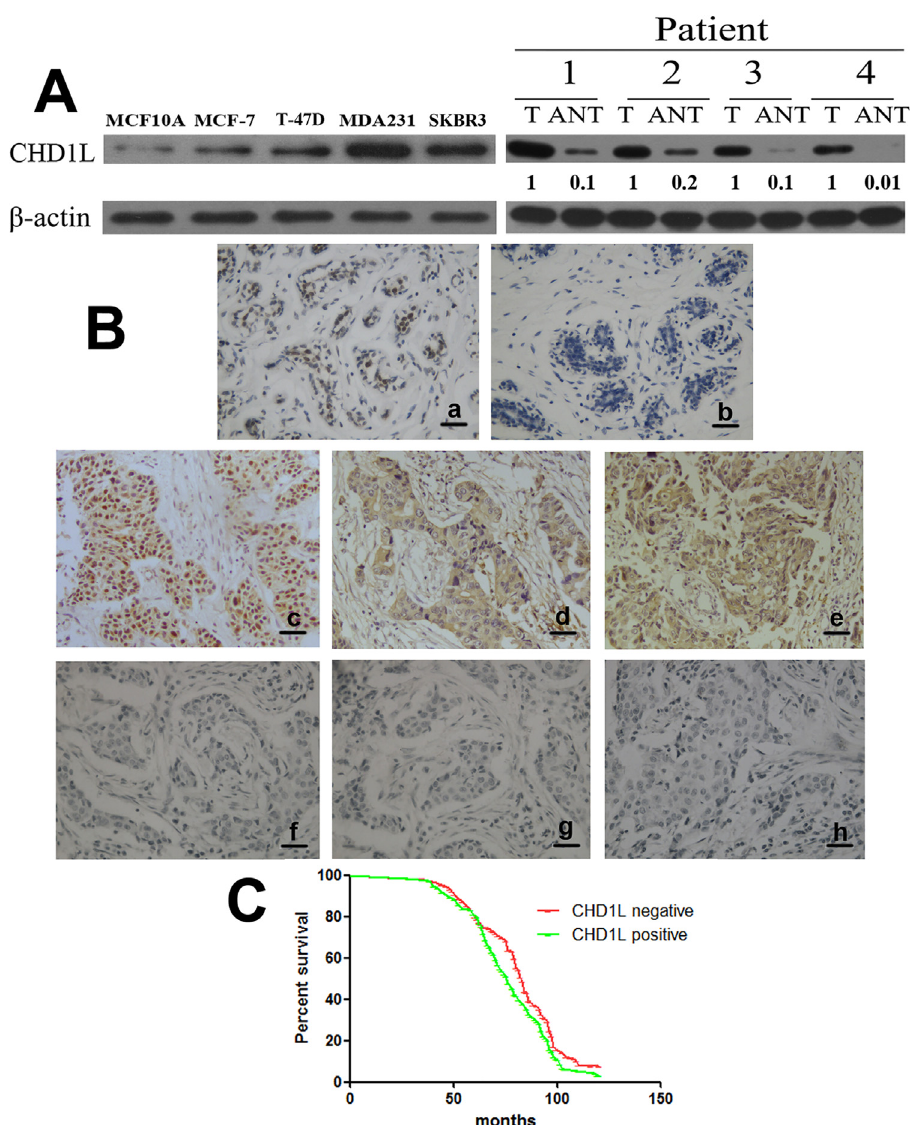
Fig 1. CHD1L is specifically upregulated in human breast cancer cell lines and tissues. (A) Left, Expression of CHD1L protein in cultured human normal mammary epithelial cell line (MCF10A) and various breast cancer cell lines (MDA-MB-231, T-47D, SK-BR-3, and MCF-7). Right, Expression of CHD1L protein in paired breast cancer tissues (T) and adjacent non-tumor tissues (ANT), with each pair obtained from the same patient. β -Actin was used as a loading control. Quantification of relative protein levels is shown below the blots. Results are representative of at least three repeated experiments. (B) Positive expression of CHD1L protein in normal mammary glands (a), negative expression of CHD1L protein in normal mammary glands (b), positive expression of CHD1L protein in carcinoma with lymph node metastasis (c), positive expression of MMP-2 protein in carcinoma with positive expression of CHD1L (d), positive expression of MMP-9 protein in carcinoma with positive expression of CHD1L (e), negative expression of CHD1L protein in carcinoma without lymph node metastasis (f), negative expression of MMP-2 protein in carcinoma with negative expression of CHD1L (g), and negative expression of MMP-9 protein in carcinoma with negative expression of CHD1L (h) were examined using immunohistochemical staining. Scale bar: 20 μ m. (C) Kaplan – Meier analysis was performed between the CHD1L level and overall survival of breast cancer patients with positive (n = 112) and low (n = 156) CHD1L